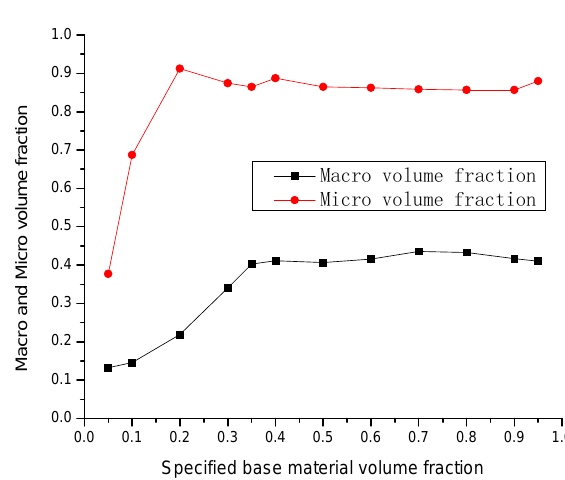
Fig. 5. Trend of macro/micro volume fraction with increasing of specified material volume